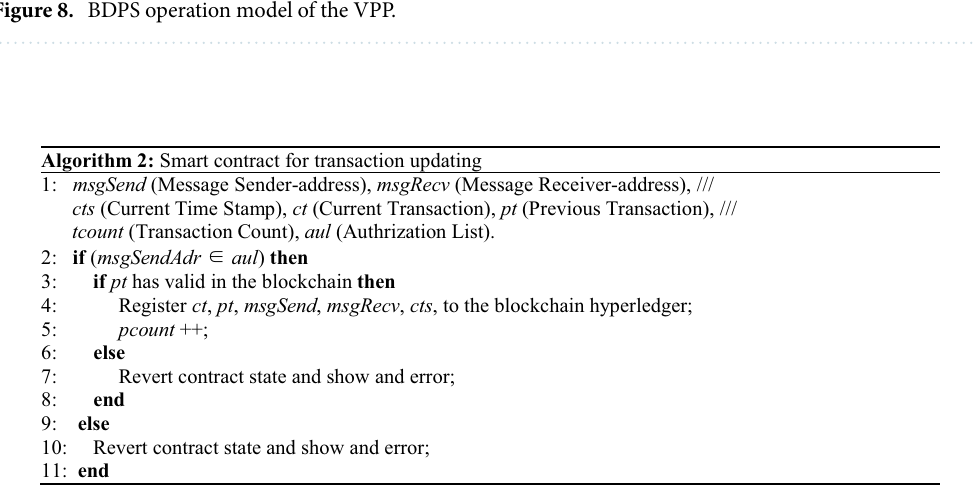
Figure 8. BDPS operation model of the